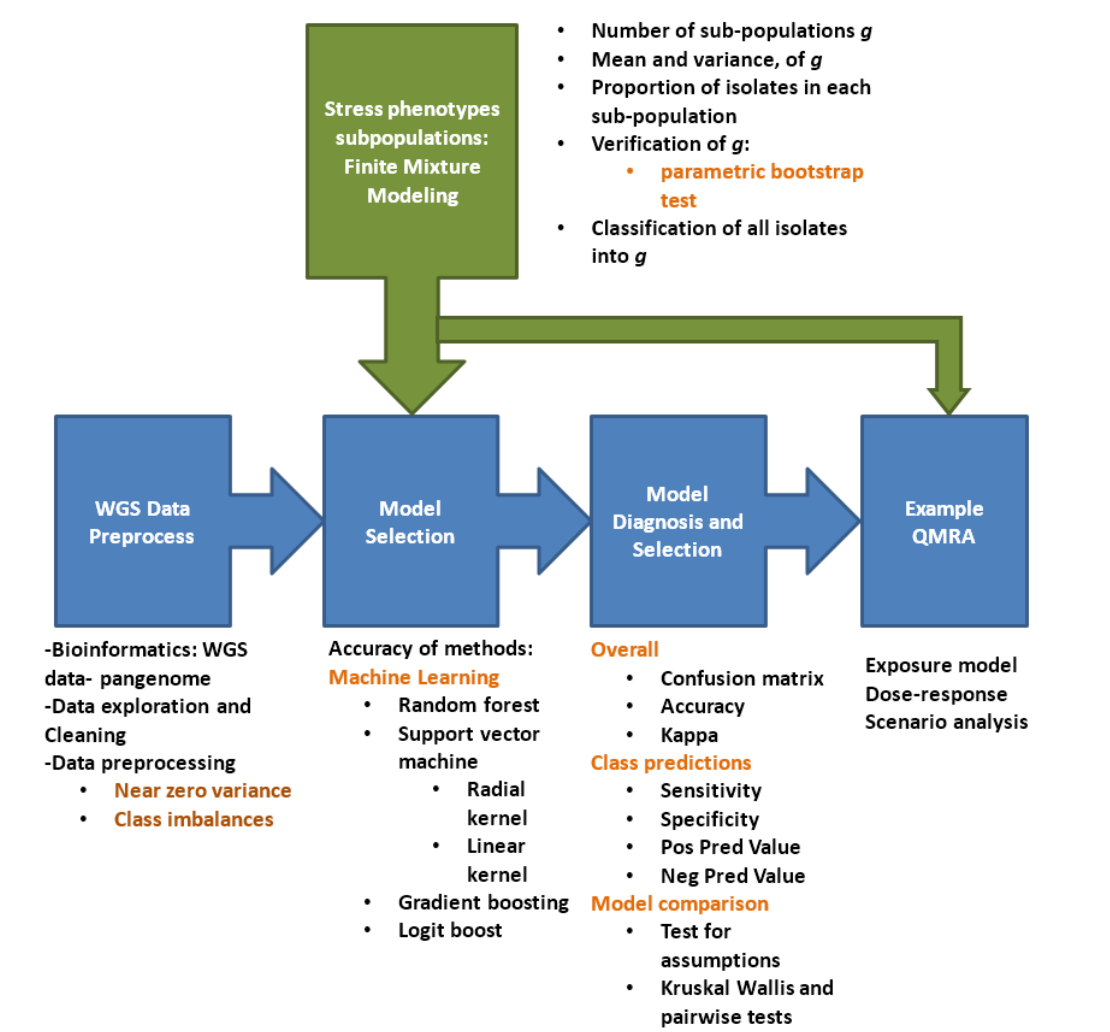
Figure 2. Methodology flow